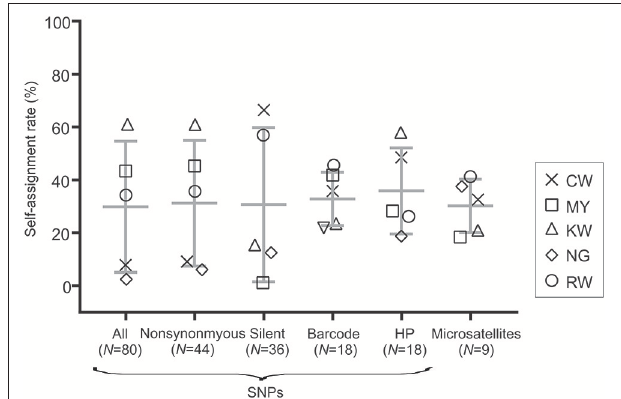
FIGURE 3 | Box plot showing self-assignment rate (%) using the Training, Holdout, Leave-one-out (THL) double cross-validation method in gsi_sim for the different SNP panels and microsatellite markers. Values of mean and standard deviation for each marker set were indicated.